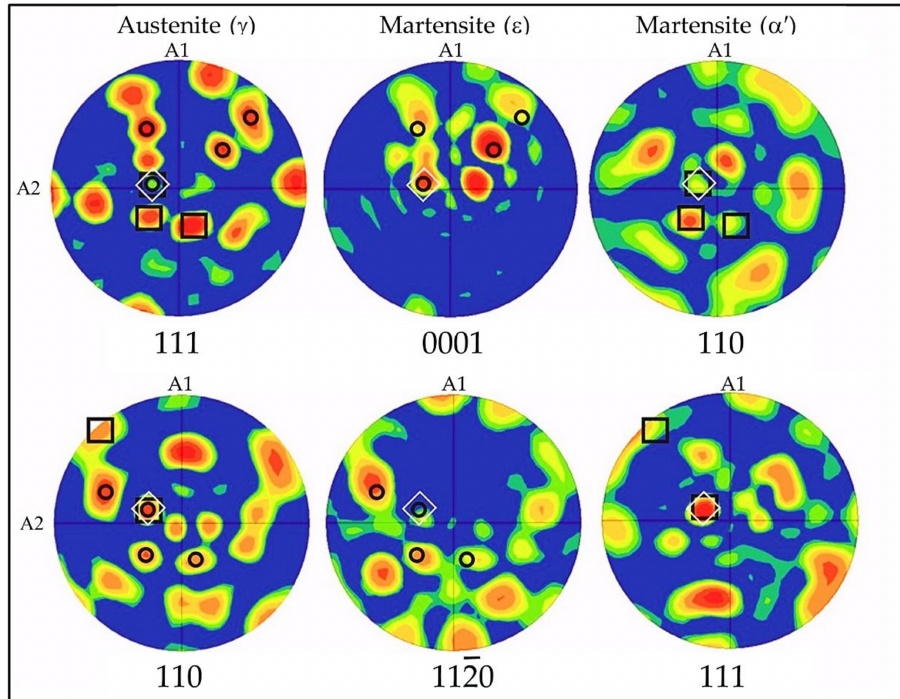
Figure 16. Pole figures showing the local textures for γ -austenite, ε - and α (cid:48) -martensites as well as S-N and K-S orientation relationships between the three phases, Fe-Mn-Al-Si steel after 30% of tensile